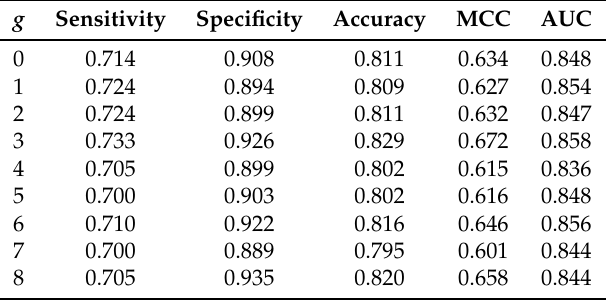
Table 1. Detailed predictive results of the current method trained by g -gap dipeptide composition with different g . g Sensitivity